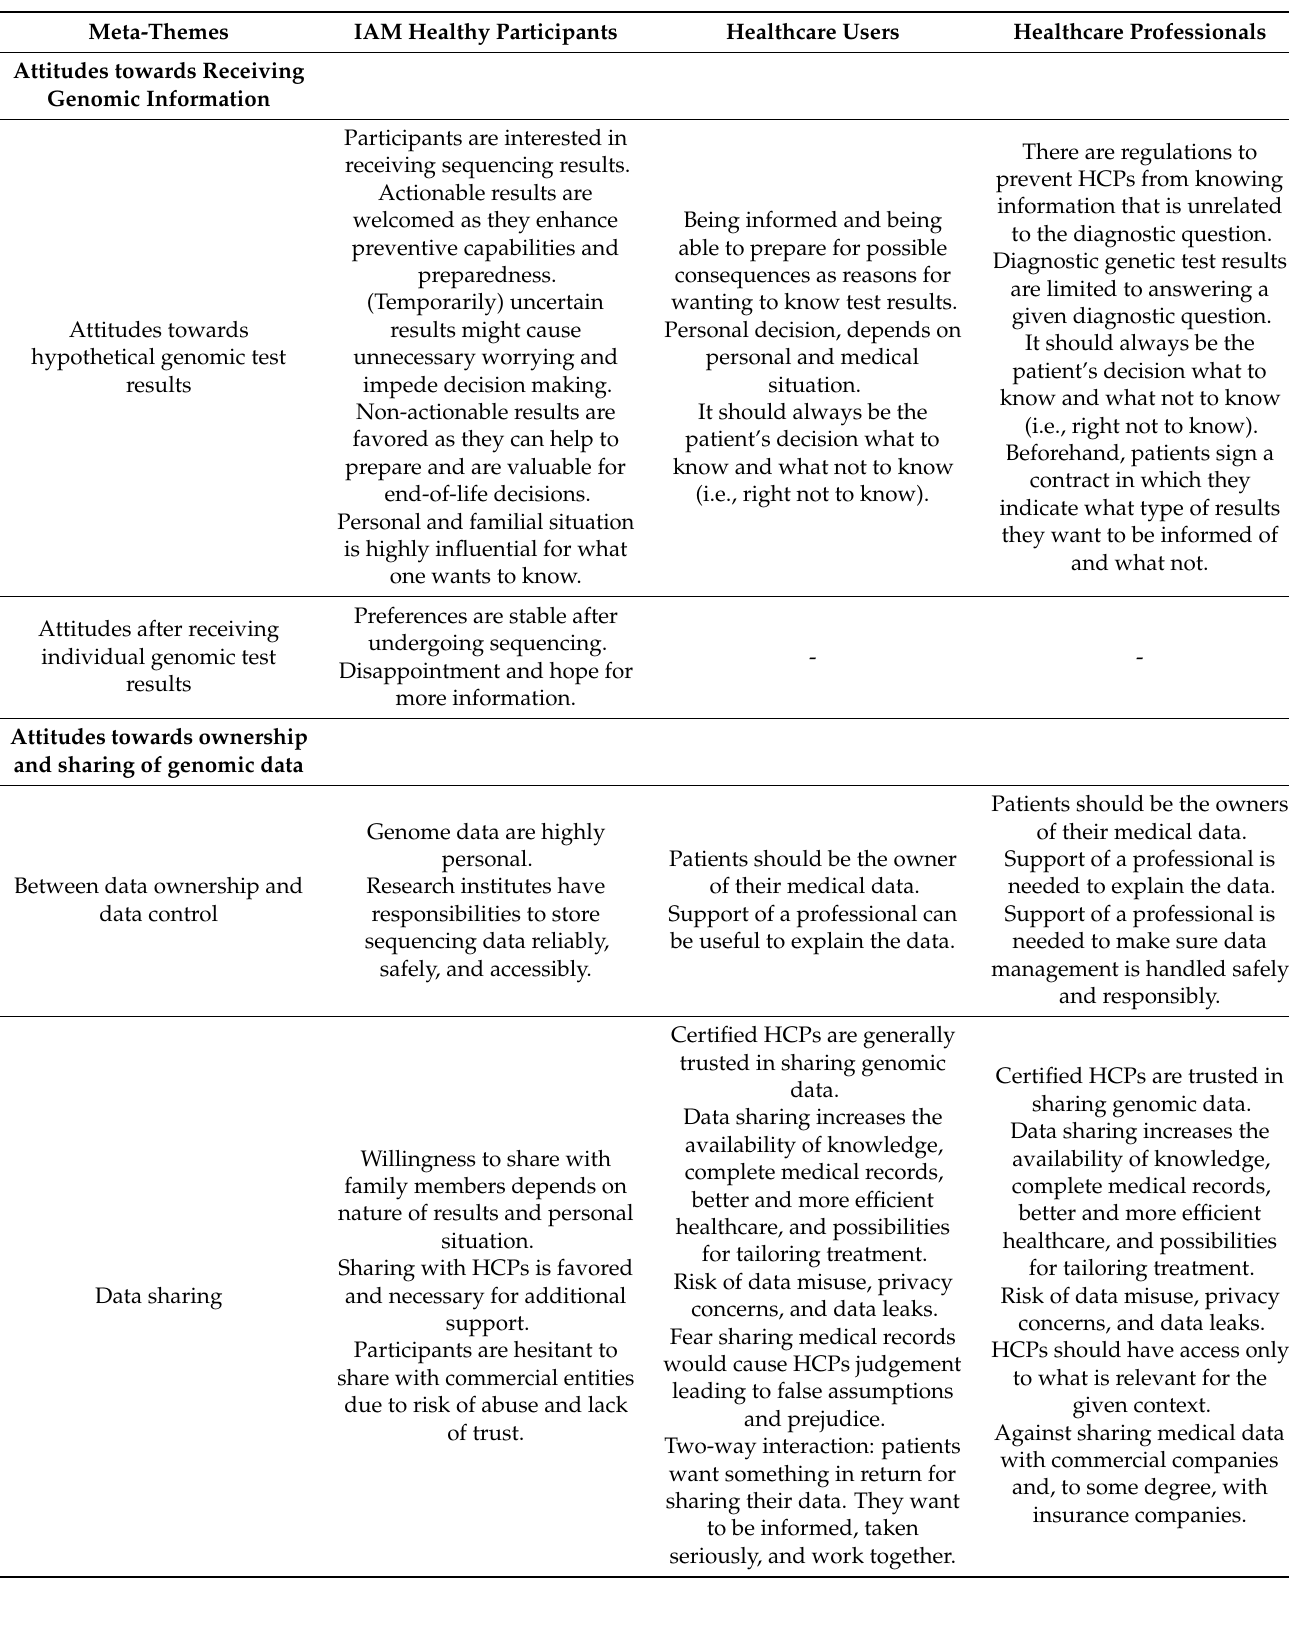
Table 3. Meta-themes and subthemes generated from the IAM interviews and PGL focus